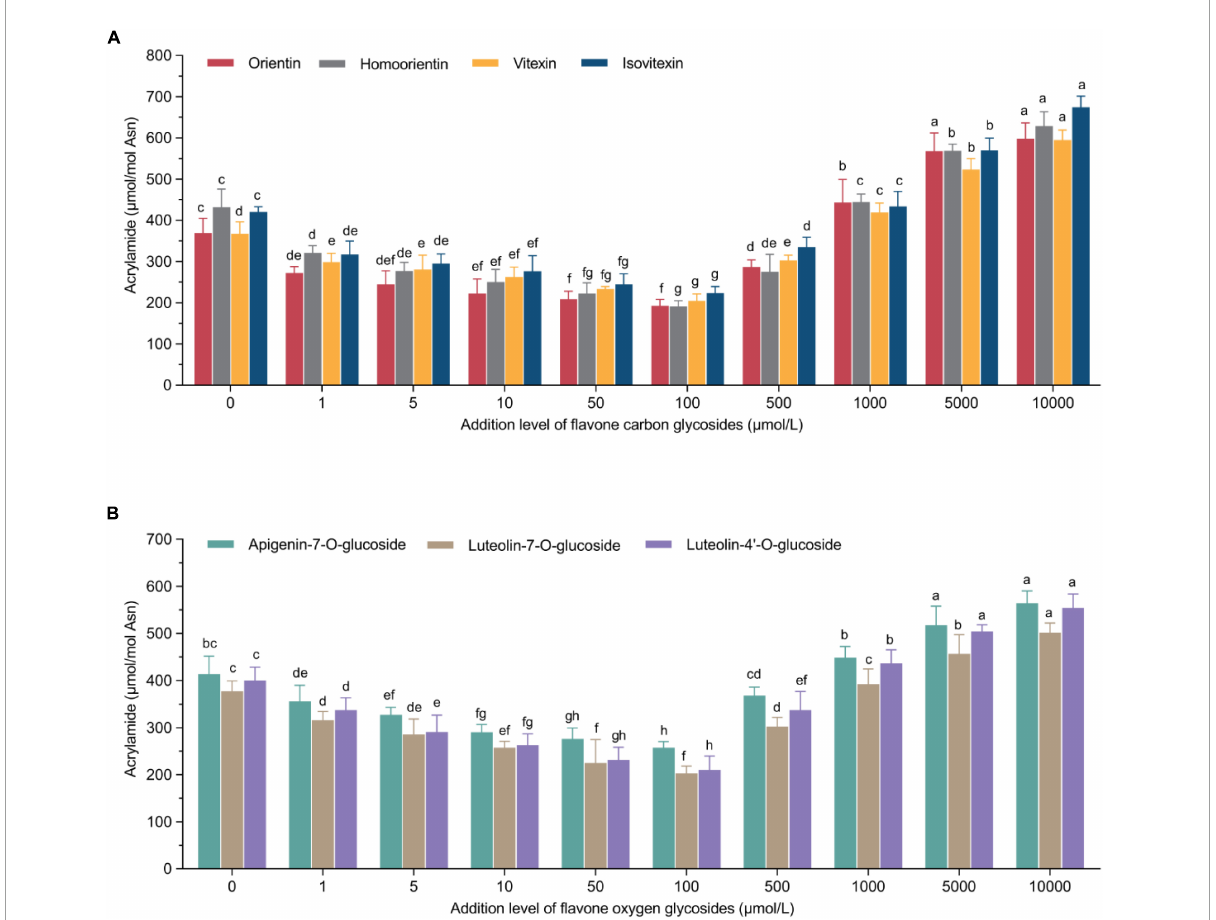
FIGURE1 U-shaped correlations between acrylamide concentrations and treatment levels of (A) flavone carbon glycosides or (B) flavone oxygen glycosides. Data are shown as the mean ± SD ( n = 3). Values with different letters indicate significant differences between different additional levels at the same flavonoid ( P <